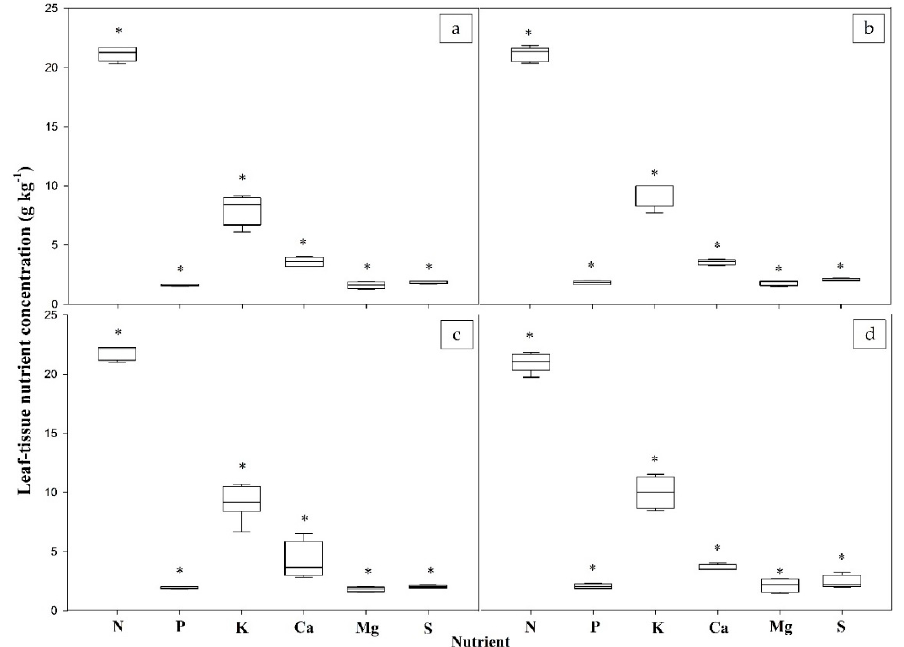
Figure 7. Leaf-tissue concentration of N, P, K, Ca, Mg, and S in sugarcane grown under straw removal rates of 0 ( a ), 25 ( b ), 50 ( c ), and 100% ( d ) in Area 2. Shapiro–Wilk Test for normal distribution, where: * significant ( p < 0.05) and ns not significant. When significant, it indicates that the hypothesis for normal distribution is rejected.